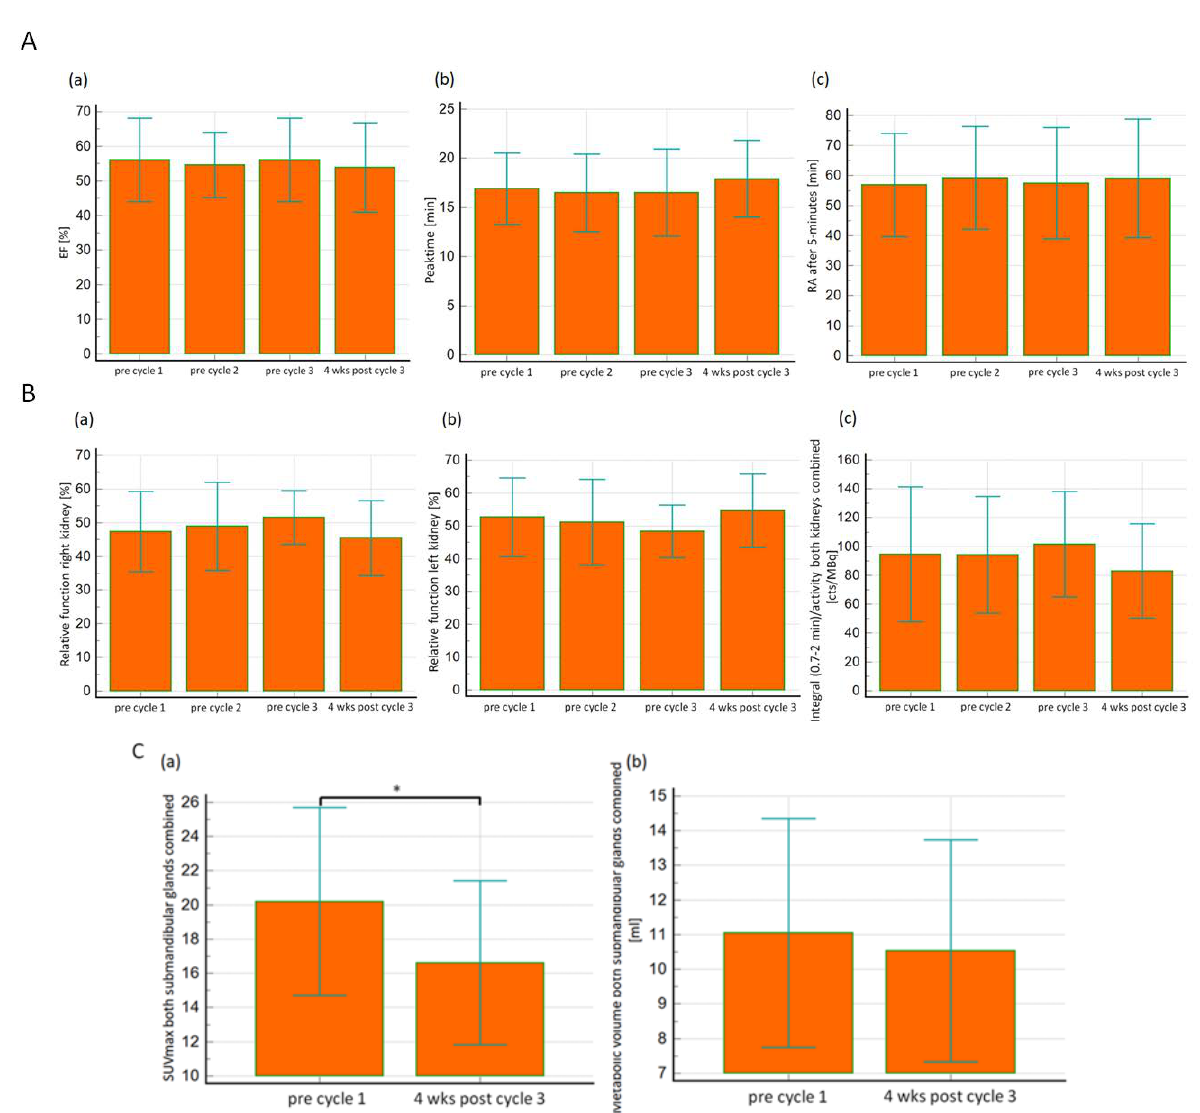
Figure 2. ( A ) Salivary gland scintigraphy prior to each three cycles of PSMA-RLT and four weeks after the third cycle. No significant difference in salivary gland function for percentage of ejection fraction (EF) (a) peak time (b) and RA after 5 min (c) for the whole parotid and submandibular glands prior to each three cycles of therapy and four weeks after the third cycle. wks.: weeks. ( B ) Kidney scintigraphy prior to each three cycles of PSMA-RLT and four weeks after the third cycle. Relative renal function such as slopes of the right (a) and left (b) Patlak as well as the integral of both kidneys combined from 0.7 to 2 min over the renogram curves normalized to the injected activity (c) did not reveal significant differences between the 3 therapy cycles and one month after the third cycle in all studied patients. wks.: weeks. ( C ) Quantification of the [ 68 Ga]Ga-PSMA PET before the first cycle and 4 weeks after the last PSMA-RLT cycle. Significant reduction in values of SUVmax (a) without changes in metabolic volume (b) of the whole submandibular glands after receiving 3 cycles of PSMA-RLT. wks.: